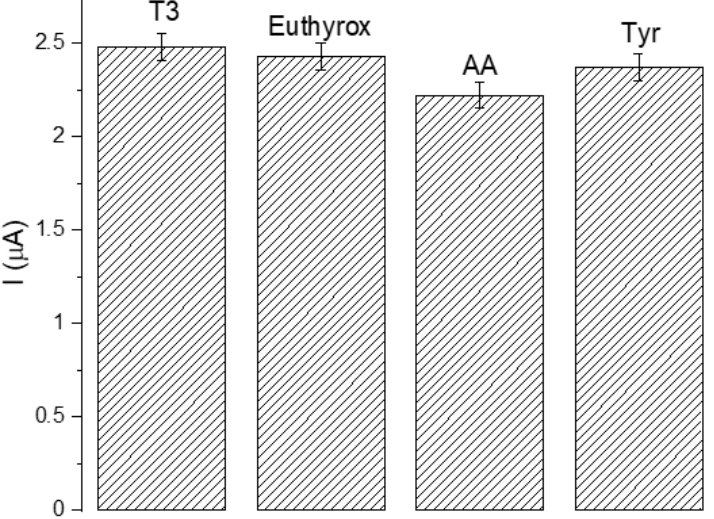
Figure 7. Influence of interfering substances (50 µM) on fT3 detection.